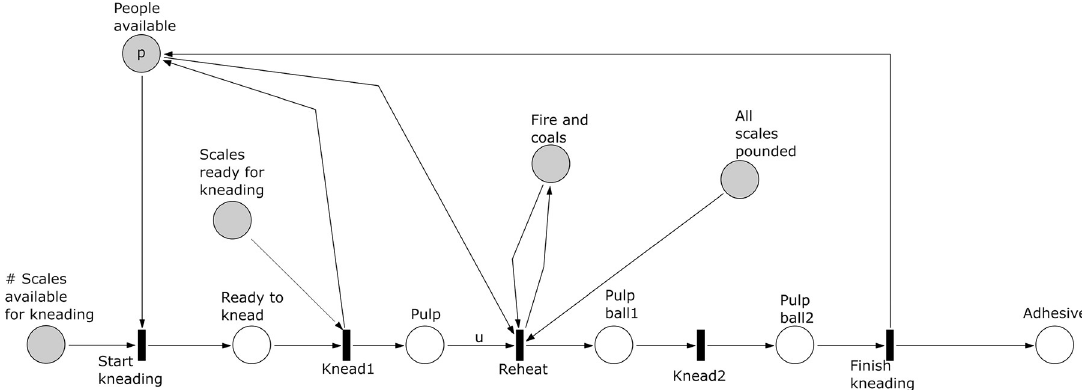
Fig 10. Subprocess 8 Knead of the A . coranica